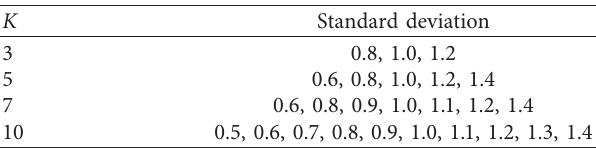
The better average values of these algorithms for each instance are given in bold and italics. Table 6: The standard deviations of Gaussian models adopted by each K